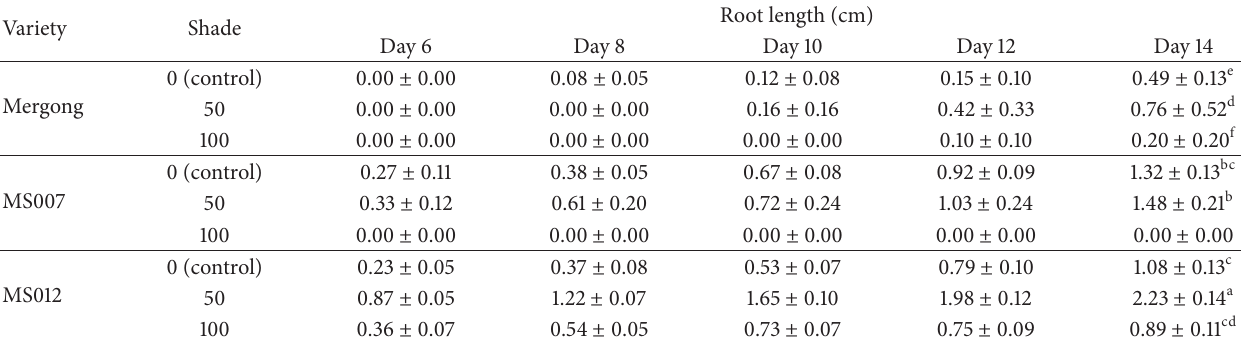
Table 14: Mean root length of three varieties treated with 50% and 100% of shade treatments from day 6 to day 14. Variety